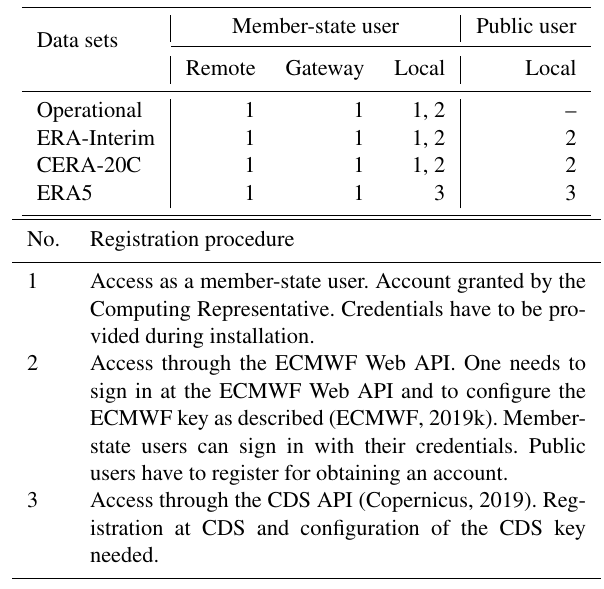
Table 6. Necessary account registrations per user and application mode for each data set. The registration procedure is indicated by numbers 1–3 and explained below.